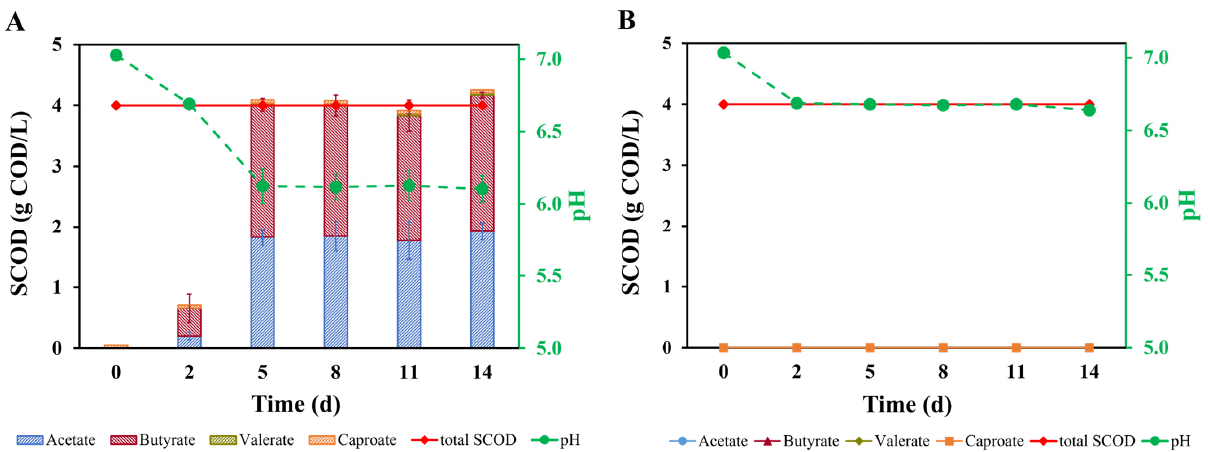
Figure 3. A . Total SCOD of supplied PHBV (as hydrolysate), SCOD (as carboxylates), and pH during mixed-culture fermentation, B . Total supplied SCOD (as hydrolysate) and pH change in the control group experiment. during mixed-culture fermentation, ( B ). Total supplied SCOD (as hydrolysate) and pH change in the control group